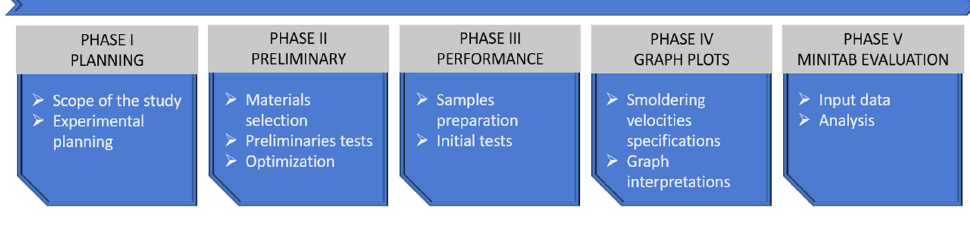
Figure 1. Work Figure 1. Work methodology.